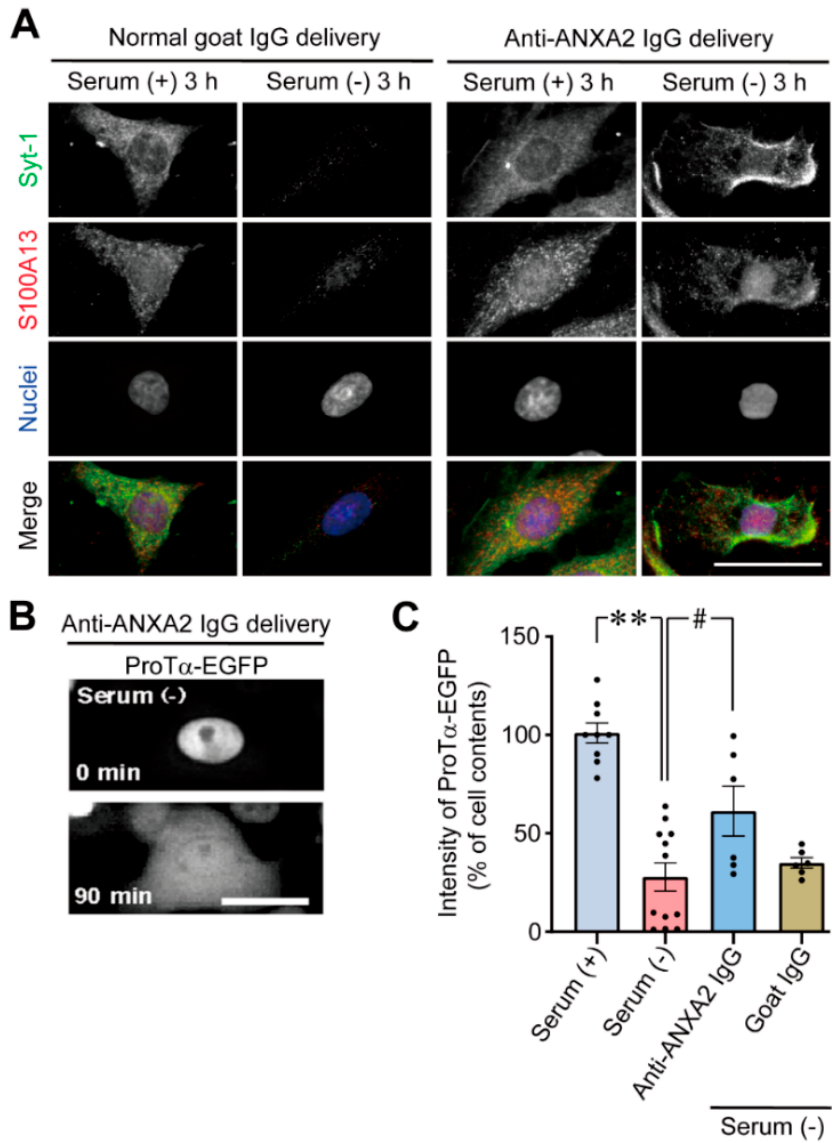
Figure 3. Involvement of annexin A2 inSyt-1, S100A13 and ProT α release under serum-free conditions. ( A ) Blockade of stress-induced release of Syt-1 and S100A13 from C6 glioma cells by intracellular delivery of anti-annexin A2 (ANXA2) IgG. Results represent the representative images of immunoreactive Syt-1 and S100A13 localization by intracellular delivery of normal goat IgG (left panels) and anti-ANXA2 IgG delivery (right panels) under the conditions of serum (+) or serum ( − ). ( B ) Blockade of stress-induced release of ProT α -EGFP from C6 glioma cells by intracellular delivery of anti-ANXA2 IgG. Results represent the representative images of ProT α -EGFP by anti-ANXA2 IgG delivery. ( C ) Reversal of stress-induced loss of ProT α cell contents by intracellular delivery of anti-ANXA2 IgG (goat), but not by the goat IgG delivery in C6 glioma cells. Results represent the cellular levels of ProT α -EGFP intensity by indicated treatments, in % levels compared with serum (+). Data are presented as the mean ± S.E.M. from a Tukey–Kramer multiple comparison test. ** p < 0.01 and # p < 0.05. n = 9 experiments (serum-containing conditions), n = 12 experiments (serum-free conditions), n = 6 experiments (goat anti-ANAX2 IgG under serum-free conditions), n = 6 experiments (goat IgG under serum-free conditions). Scale bars, 20 μ m.